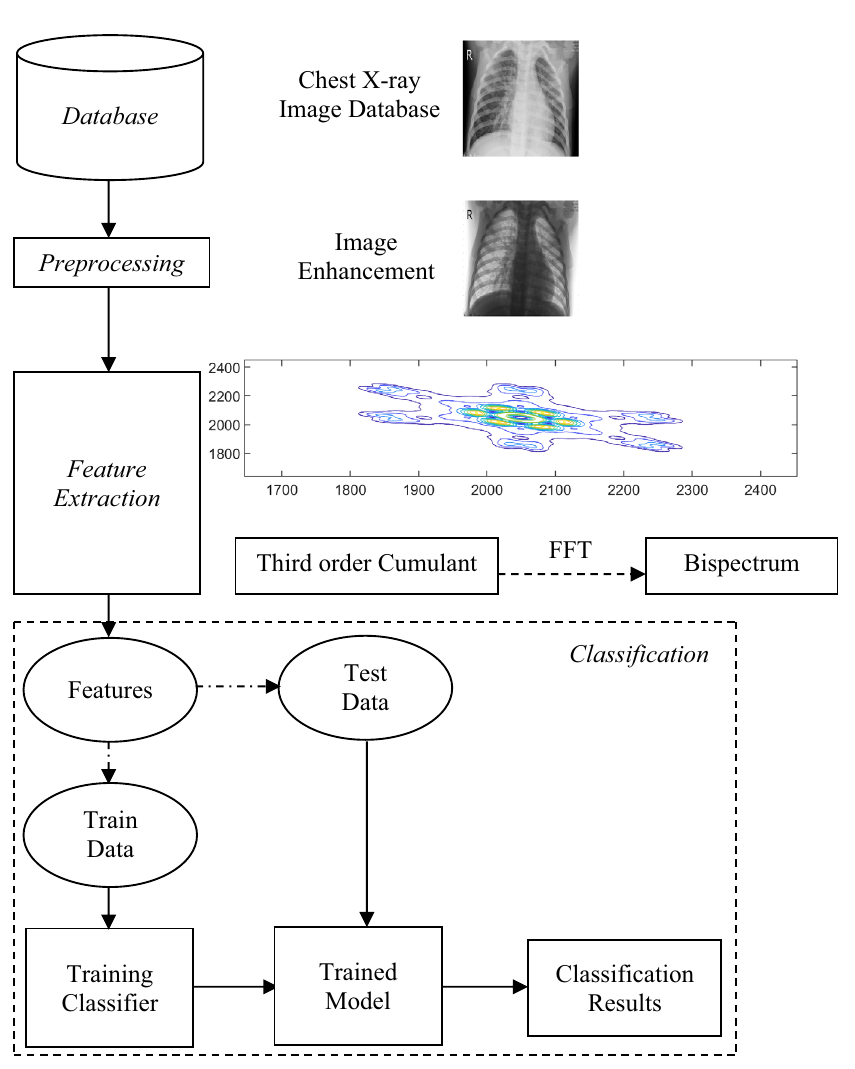
Figure 9. Block diagram of workflow in non-iterative approach of